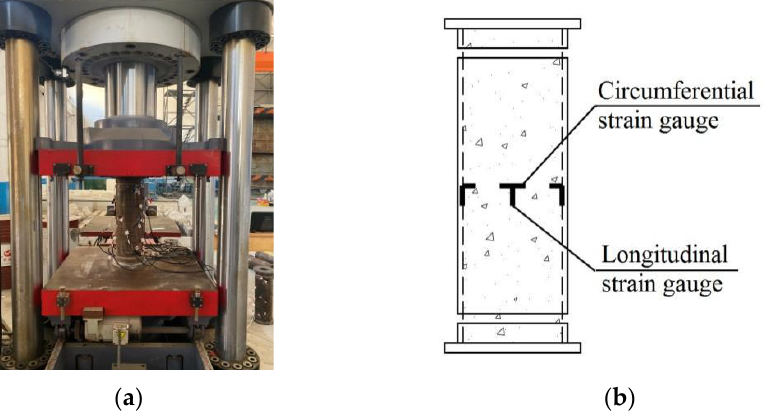
Figure 4. Testing setup and placement of the measuring points. ( a ) Axial compression test of columns. ( b )The arrangement of strain gauges.